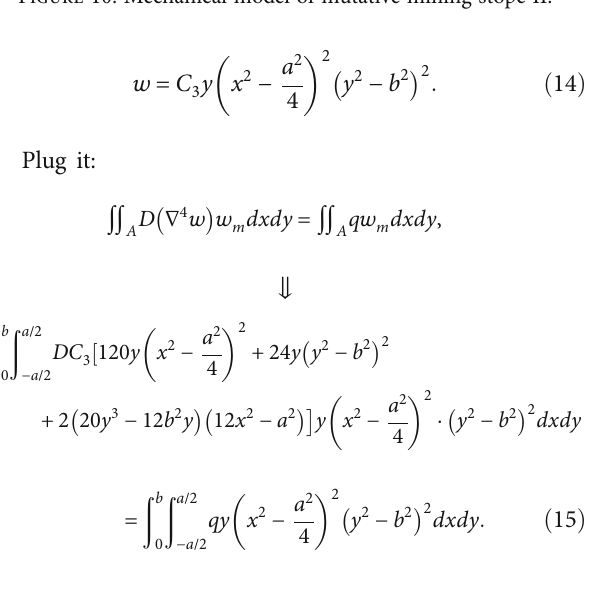
Figure 10: Mechanical model of mutative mining stope II.